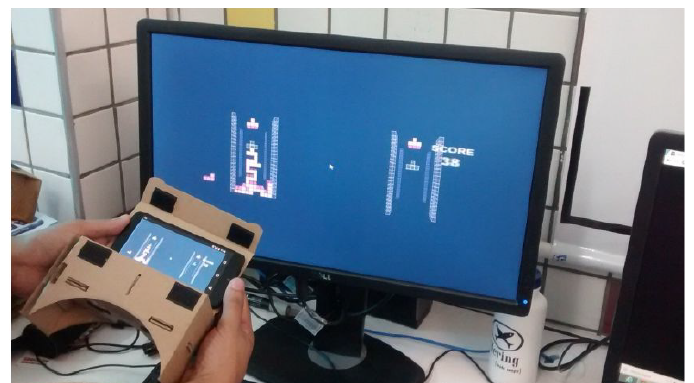
Figure 5. Atmosphere scenario.